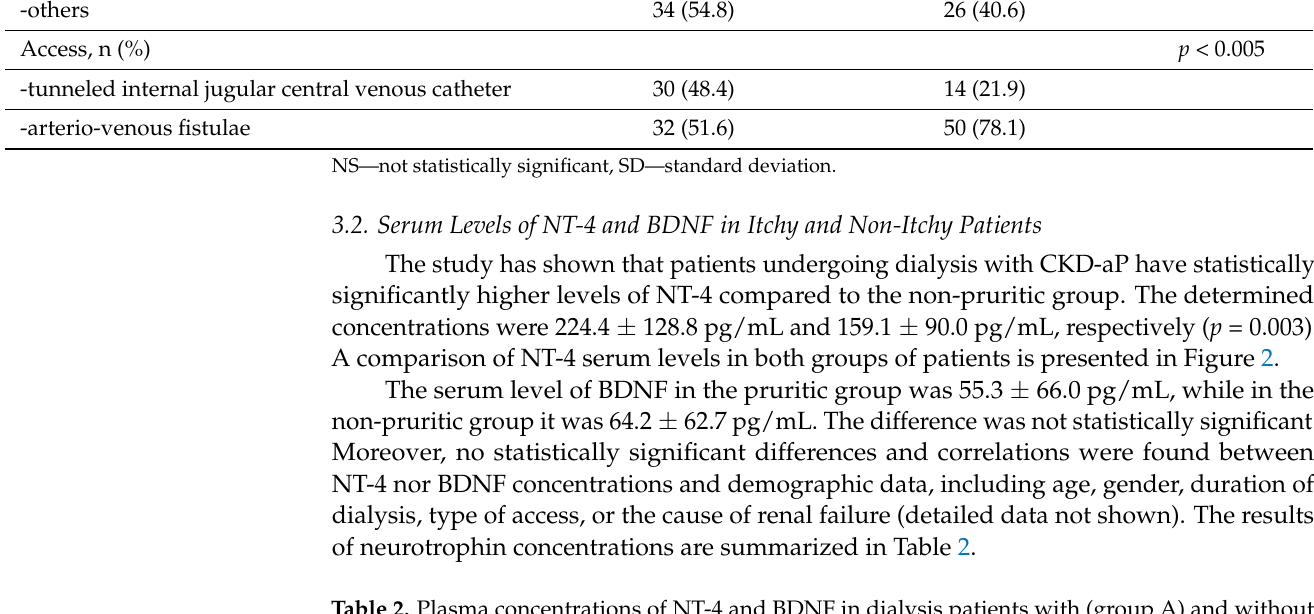
Table 2. Plasma concentrations of NT-4 and BDNF in dialysis patients with (group A) and without (group B)